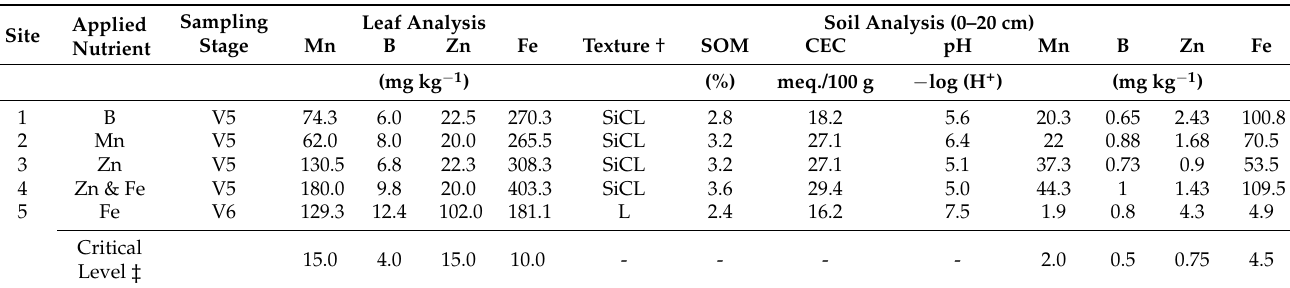
Table 2. Background leaf (V5–6) and soil characteristics for the study